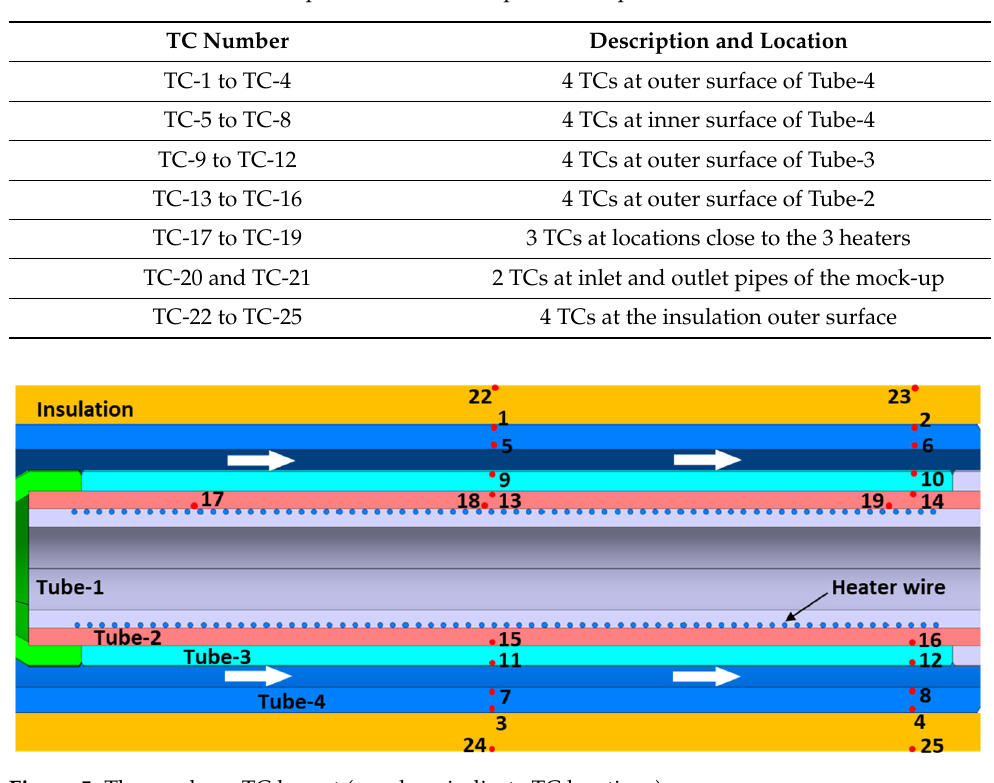
Figure 5. The mock-up TC layout (numbers indicate TC